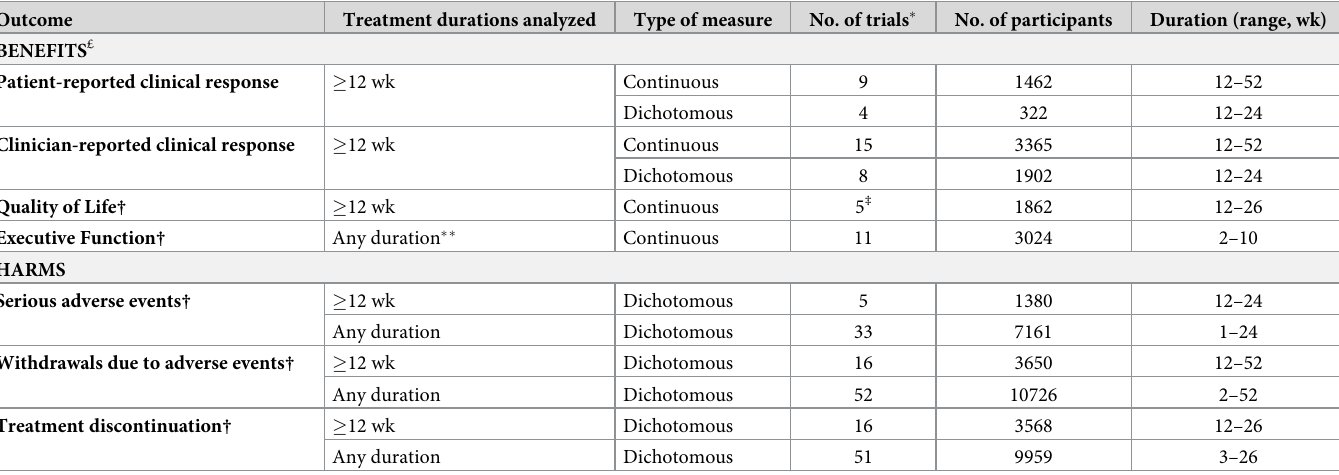
Table 2. Summary of analyses